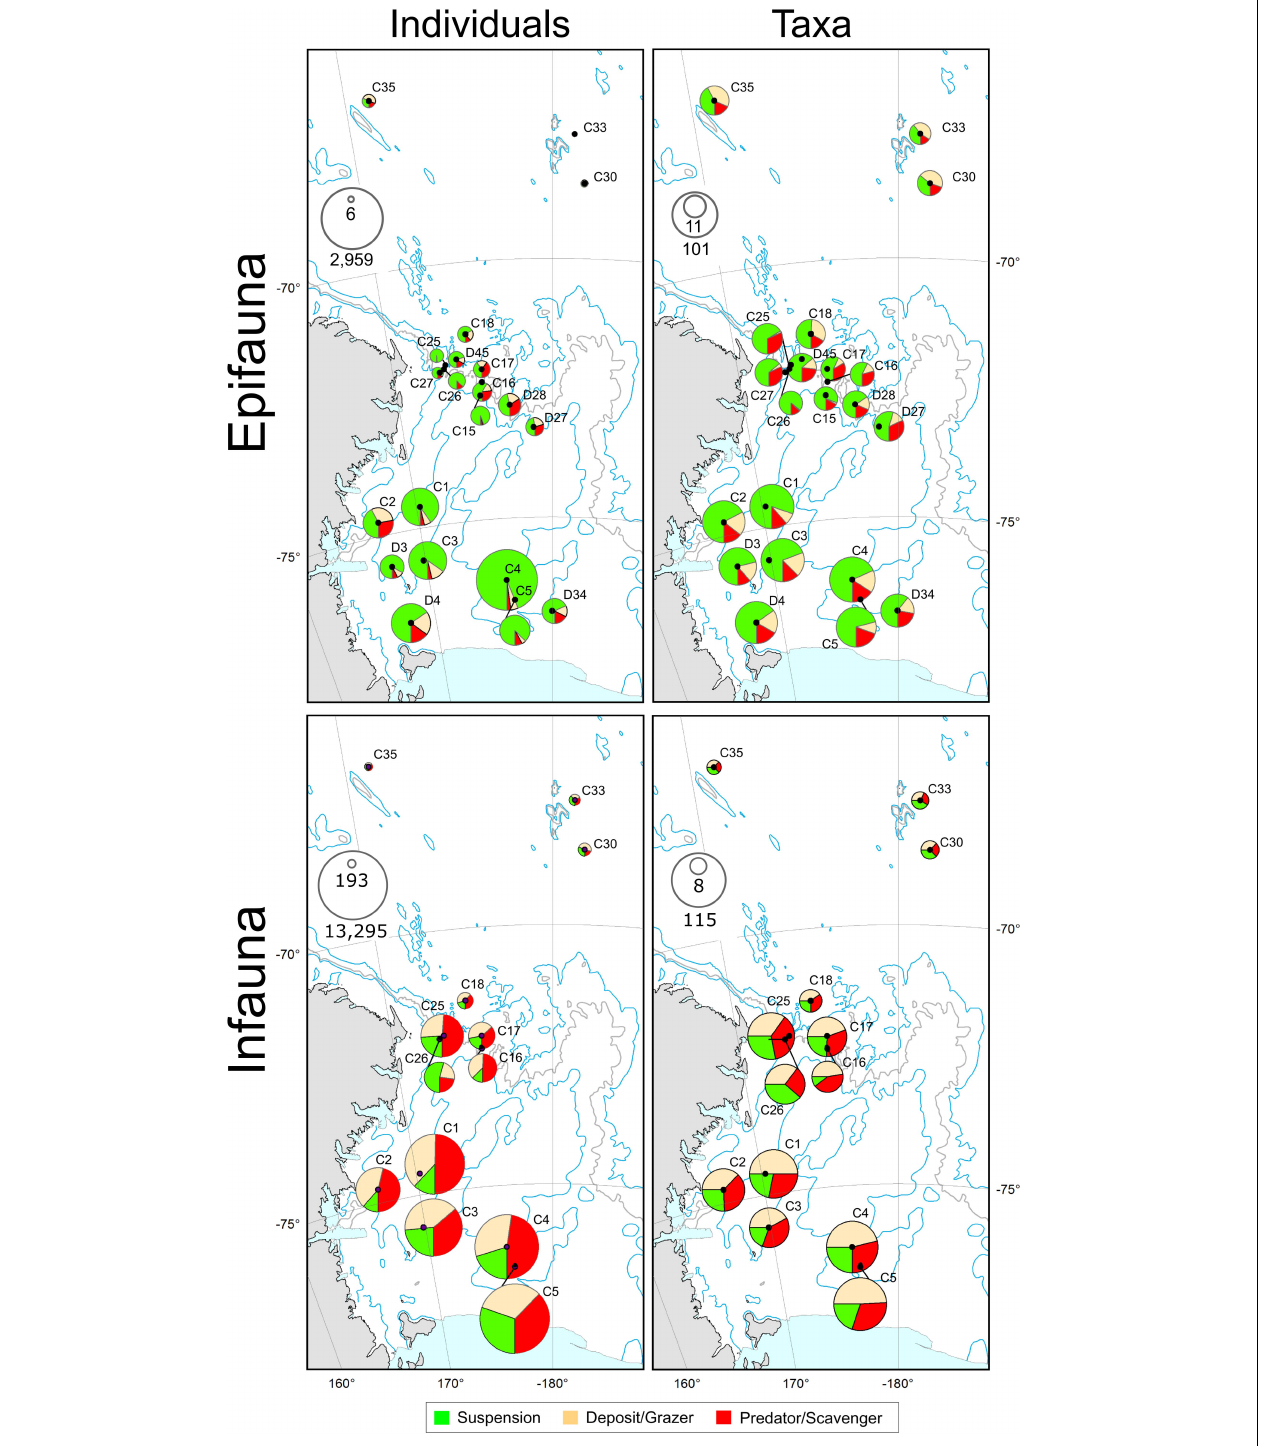
FIGURE 6 | Feeding modes of mega-epifauna (top panels) and macro-infauna (bottom panels) represented in terms of the number of individuals (left) and the number of taxa (right) exhibiting each of three feeding modes: suspension feeders; deposit-feeders or grazers; and predators/scavengers. Pie symbol diameters are scaled in proportion to the total number of individuals (see inset max-min scales: epifauna, individuals 1000 m - 2 ; infauna, individuals m - 2 ) or taxa recorded at each site, and segments indicate the relative occurrence of each feeding category. For Mega-epifauna individuals, proportions of suspension feeders, predator-scavengers, and deposit-grazers at the Abyssal sites were: C30: 0.37, 0.23, 0.40, C33: 0.16, 0.11, 0.73; C35: 0.32, 0.20, 0.48, respectively. For macro-infauna individuals proportions were C30: 0.31, 0.48, 0.21, C33: 0.37, 0.26, 0.38; C35: 0.38, 0.29, 0.34, respectively.